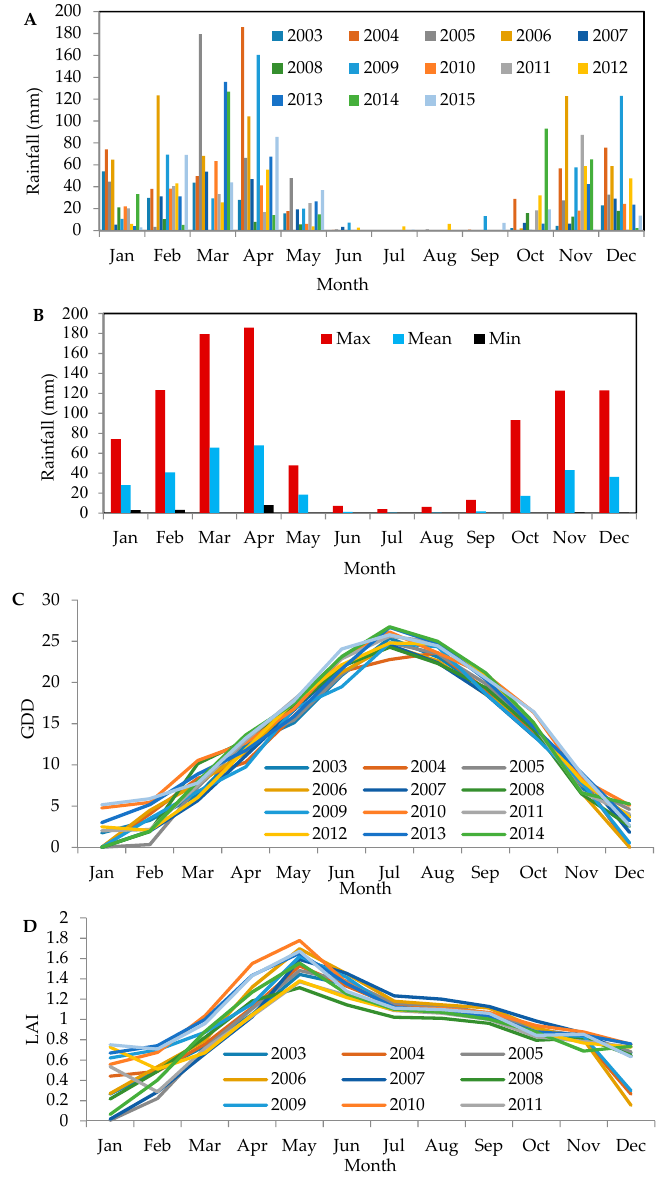
Figure 2. Spatially averaged time series of ( A ) monthly rainfall, ( B ) max, min and mean monthly rainfall, ( C ) monthly GDD and ( D ) monthly MODIS LAI.